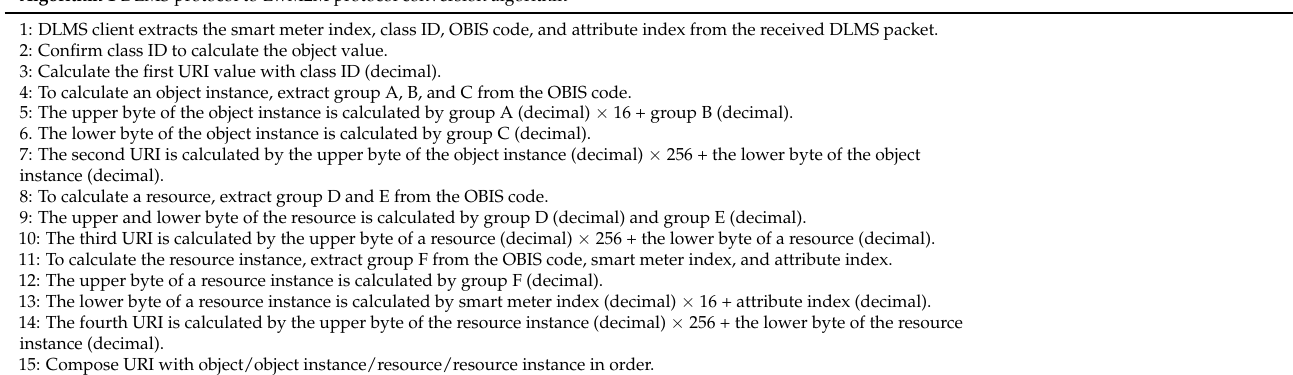
Algorithm 1 DLMS protocol to LwM2M protocol conversion algorithm